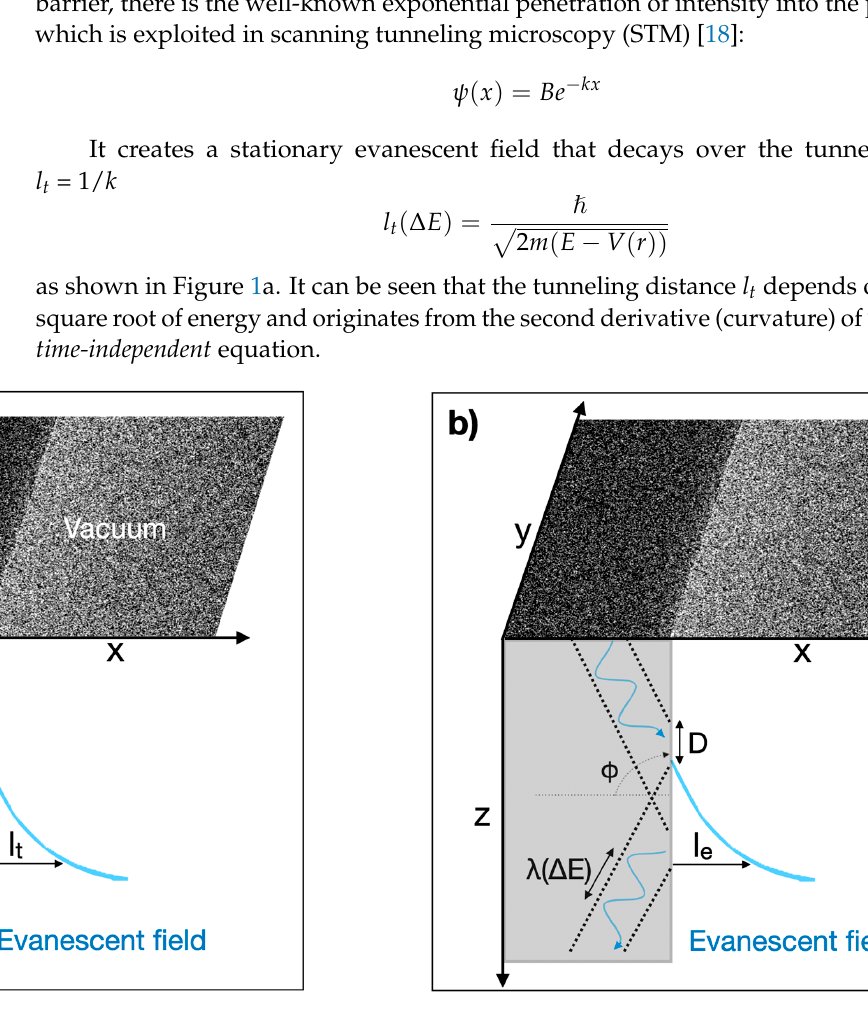
Figure 1. Schematic representation of evanescent field formations. ( a ) Time-independent solution: a trapped wave function tunnels into a potential barrier with an exponential decay length l t ; ( b ) Time-dependent solution: an incident electron wave experiences total reflection and a Goos–Hänchen shift D that creates an evanescent field of exponential decay length l e .